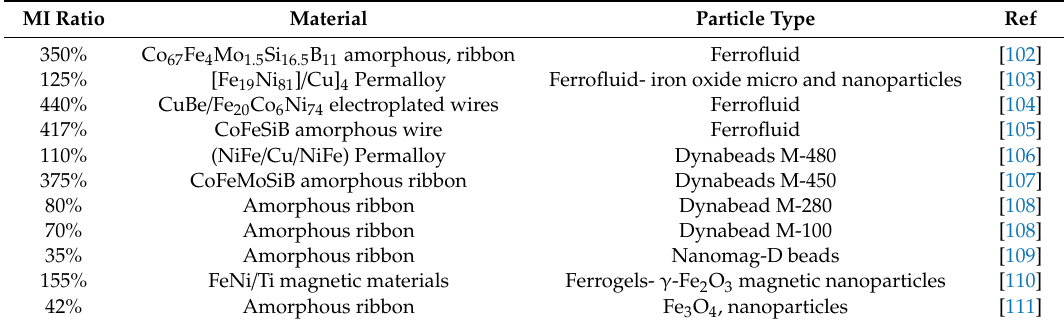
Table 2. Highest MI e ff ect based on magnetic